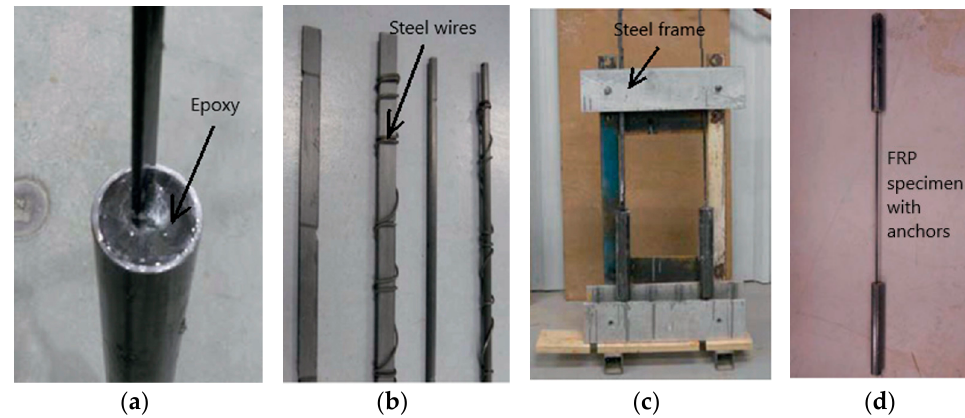
Figure 3. Fabrication of anchor system for FRP specimens indicating ( a ) epoxy filling, ( b ) steel wires, ( c ) steel frame, and ( d ) test specimen.